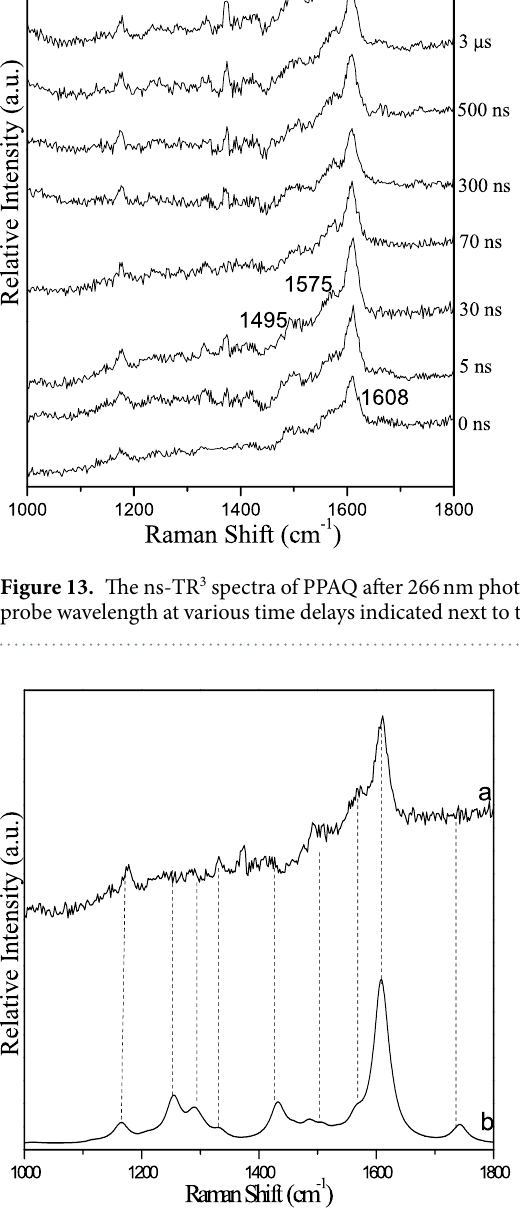
Figure 14. Shown is a comparison of ( a ) the experimental ns-TR 3 spectrum obtained at 30 ns time delay of PPAQ in pH 2 MeCN-H 2 O (1:1) to ( b ) the calculated normal Raman spectrum of the species 4 using M062X/6-311 G **